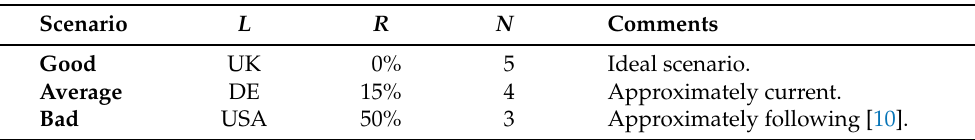
Table 7. Multivariate sensitivity analysis scenarios. High-impact remanufacturing parameters were combined into three scenarios to contextualise emission results: remanufacturing location L , used catheter rejection rate R , and number of turns N